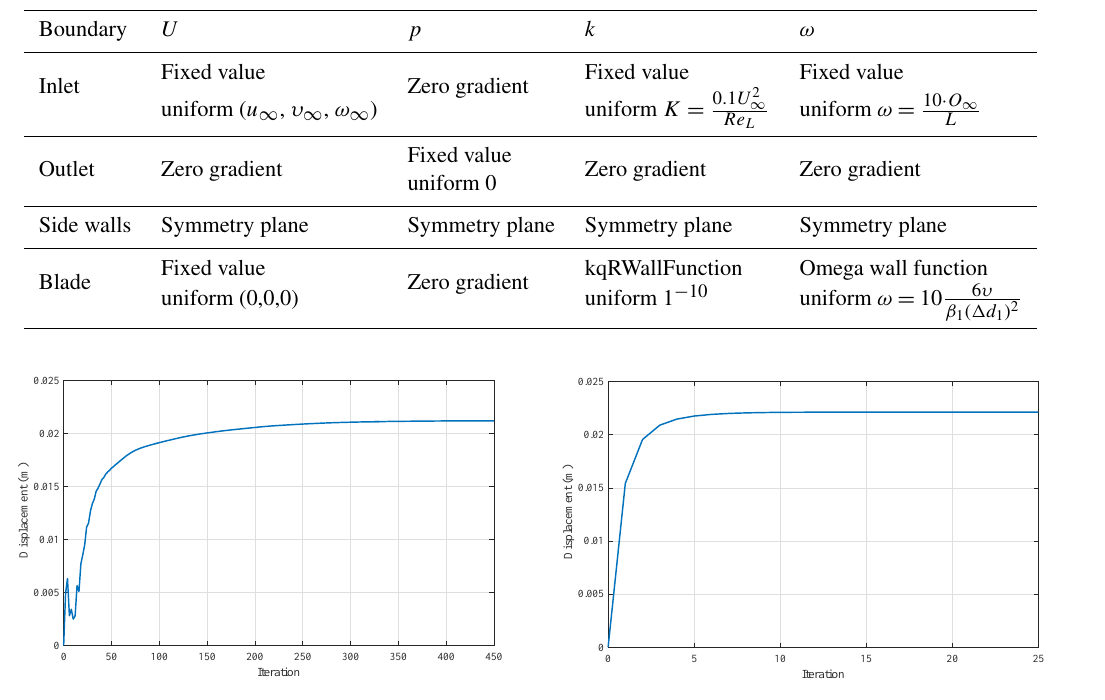
Figure 16. Convergence of the displacement for the selected monitor point. Left: FSI_CFD. Right: FSI_Panel.